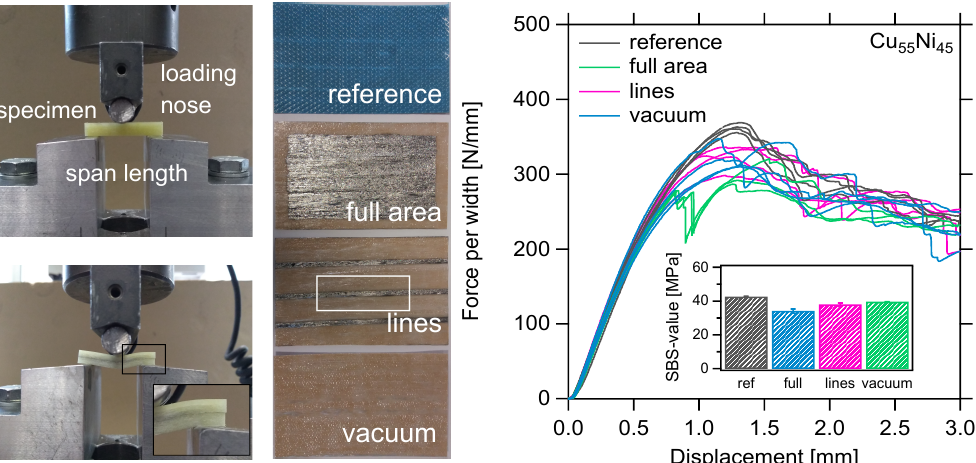
Figure 1. Left . Photograph of the short beam test set-up showing the sample before and after the test. Please note the delamination due to interlaminar shear at the mid-plane between the fully coated and the uncoated laminae. Middle . Representation of the different treatments for the mid-plane prepreg ply of the laminates used for mechanical testing: reference sample (still covered by the blue release film to symbolize the prepreg itself is untreated), fully coated area, line pattern (line width 2 mm), and uncoated prepreg but exposed to vacuum for the same duration as the coated samples. The coatings are constantan films with a thickness of 150 ± 30 nm. The white rectangle represents the 12 mm × 36 mm region cut from the laminate to perform the mechanical test. Right . Overview of the load-displacement curves of the short beam shear test for laminates with different conditions for the midplane prepreg ply (reference, fully coated by a 150 nm constantan (Cu 55 Ni 45 ) film, partially (17%) coated by lines of constantan of 2 mm width and 150 nm thick, and uncoated but vacuum exposed). Each sample was tested multiple times. The inset shows the average short-beam shear (SBS) strength. The error on these measurement is small as can be evaluated from the small error bars.